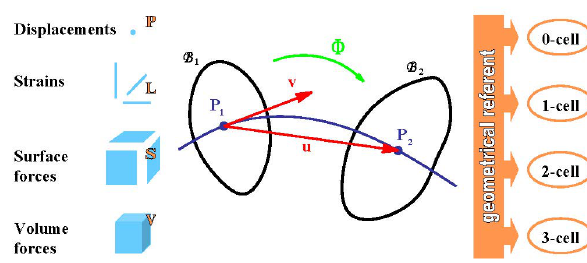
Figure 46: Association between space elements and variables in continuum mechanics.